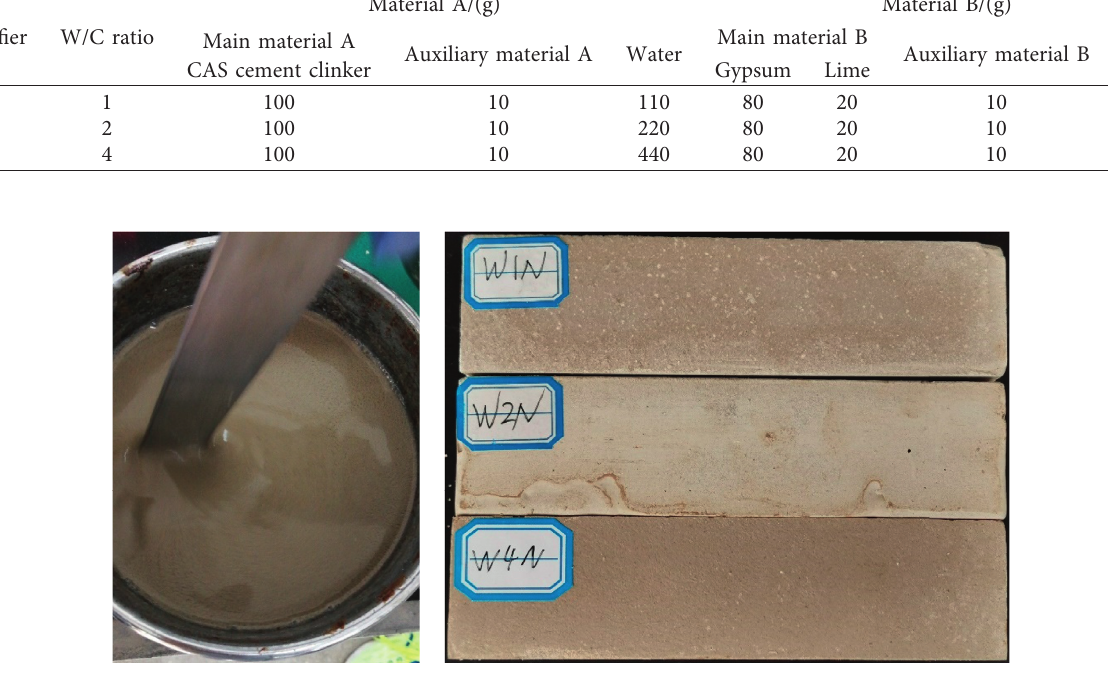
Figure 2: Preparation of NCG concretion. (a) Single slurry stirring state. (b) Setting hardening